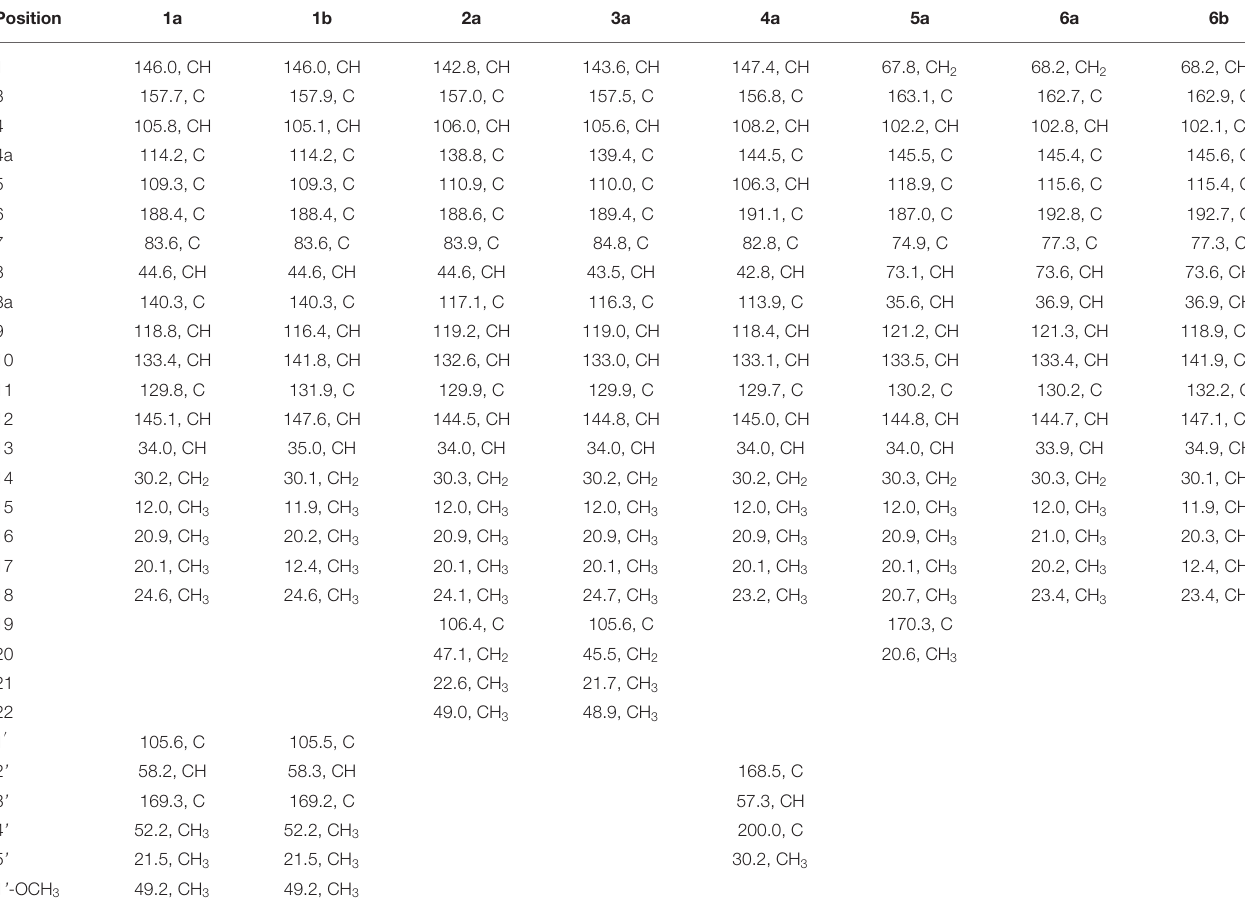
TABLE 2 | 13 C NMR data of compounds 1–6 (chloroform- d , δ in